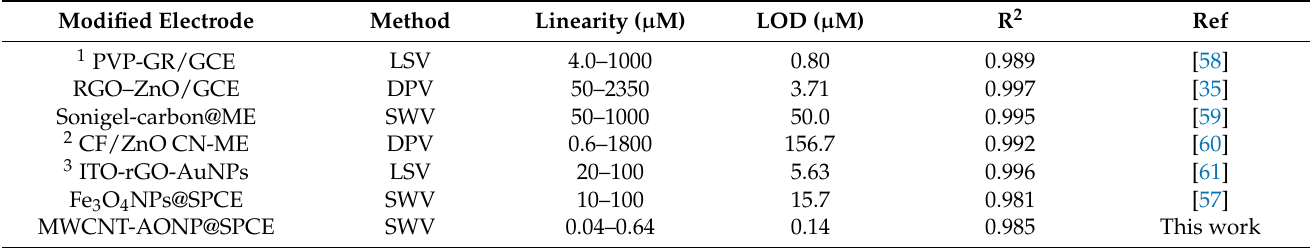
Table 1. List of AA electrochemical sensors from literature.